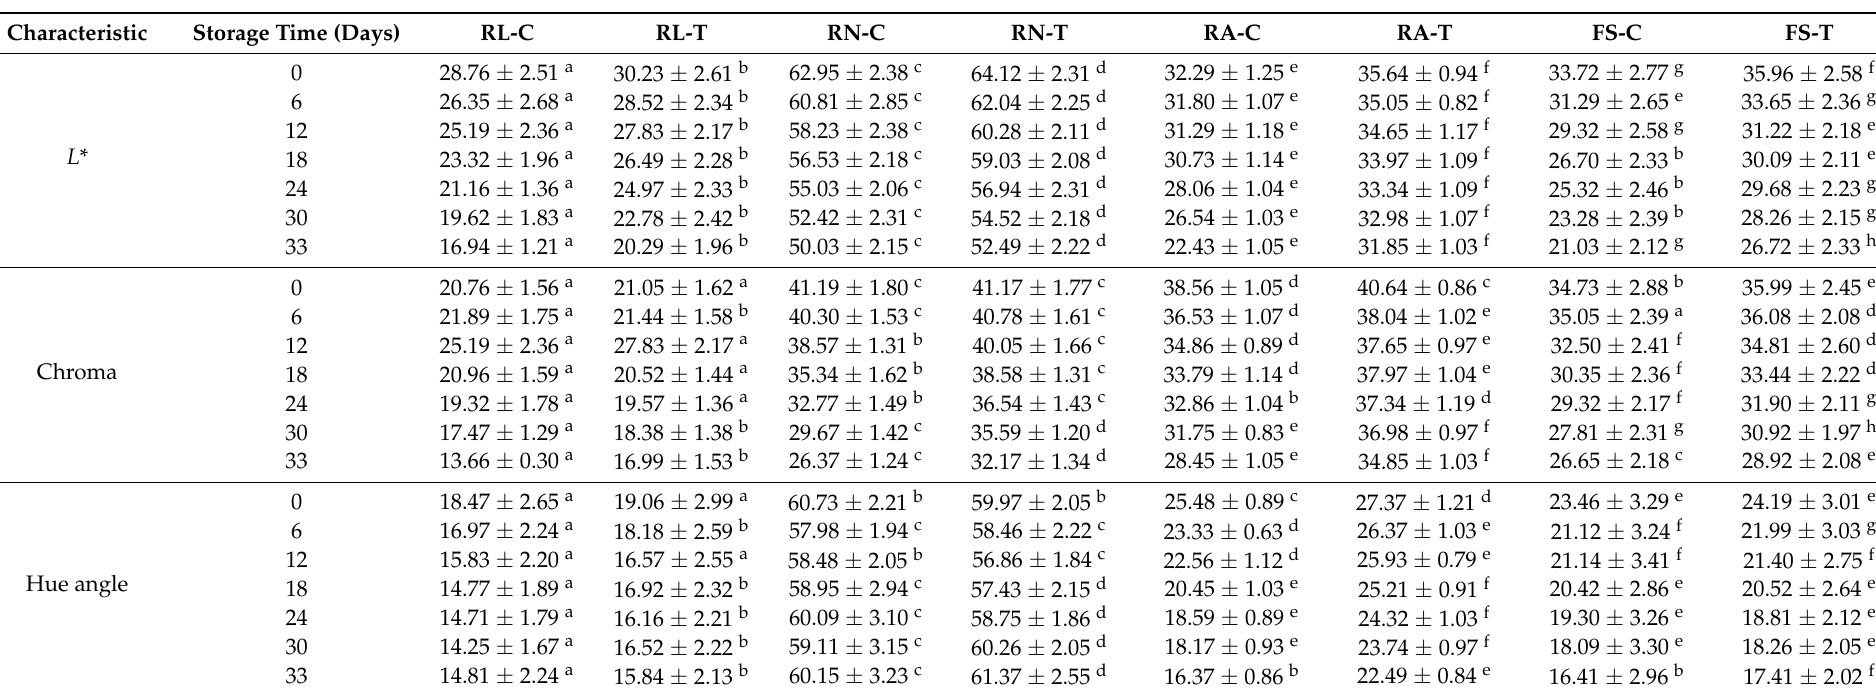
Data are mean ± standard deviation of sixty replicate tests. Different letters in the same row indicate significantly different values according to one-way ANOVA followed by Duncan’s multiple test range ( p <